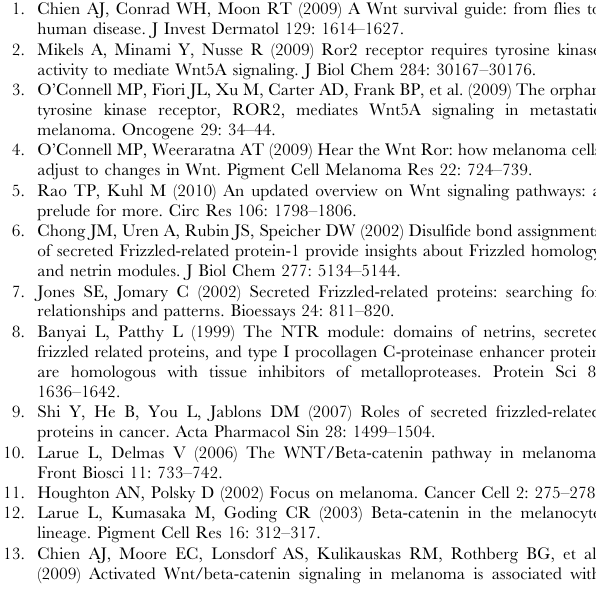
ment. Melanoma cells treated with 5 9 aza were analyzed for SFRP3 expression using immunofluorescence that was quantified by measuring the intensity from at least 6 images from each of 3 separate experiments. The data are given as Arbitrary Units (AU). *=p , 0.05. Figure S3 Analysis of rSFRP3 on melanoma cell viabil- ity. Malignant melanoma cell lines were kept in serum free media for 24 h and then treated with 1 m g/ml rSFRP3 or carrier to investigate the difference in cell viability using a WST assay. A , A2058 cells treated for 24 h. B , A2058 cells treated for 48 h. The error bars represent SD (n= 3). (PDF) Figure S4 QPCR analysis of Wnt5a knockdown by siRNA. Wnt5a was knocked down in A2058 cells and then analyzed by QPCR. Wnt5a expression was normalized against the housekeeping genes YWHAZ, UBC and SDHA and is expressed as relative expression compared to Scrambled siRNA control. (PDF) Figure S5 Analysis of SFRP3 over-expression. HTB63 cells were transfected with pCMV6- AC-GFP or pCMV6-AC- GFP-FrzB (Origene) and kept in serum-free media for 24 h. Expression was analyzed using quantitative RT-PCR.